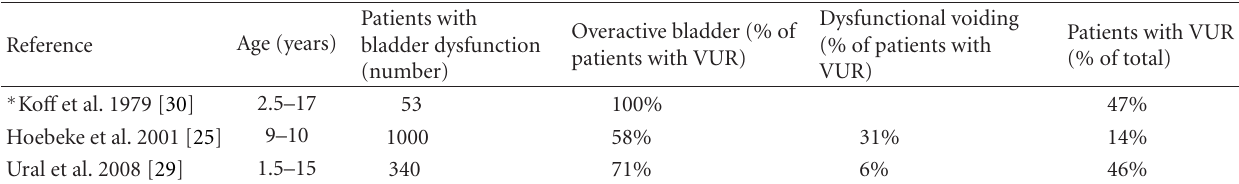
Table 2: Prevalence of VUR in patients with bladder dysfunction. Urodynamic studies.